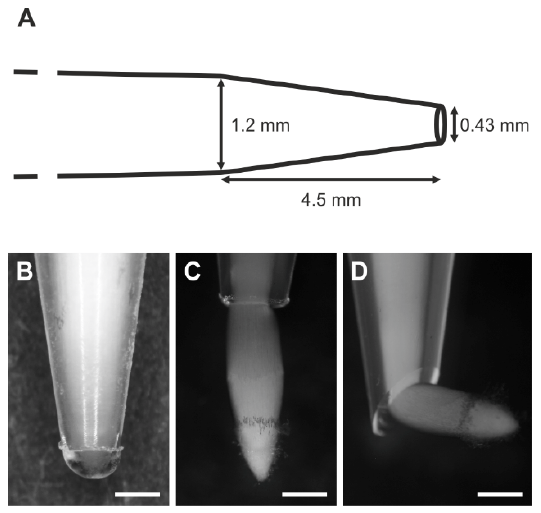
Figure 2. The experimental set-up. ( A ) Geometrical dimensions of the plastic tube. ( B – D ) The ana- lyzed stages/variants of the experiment: stressed root apex reaching the tube ending ( B ), recovering root apex growing out of the tube in untouched ( C ) and obliquely cut ( D ) tube ending. Scale bars: 0.5 mm.